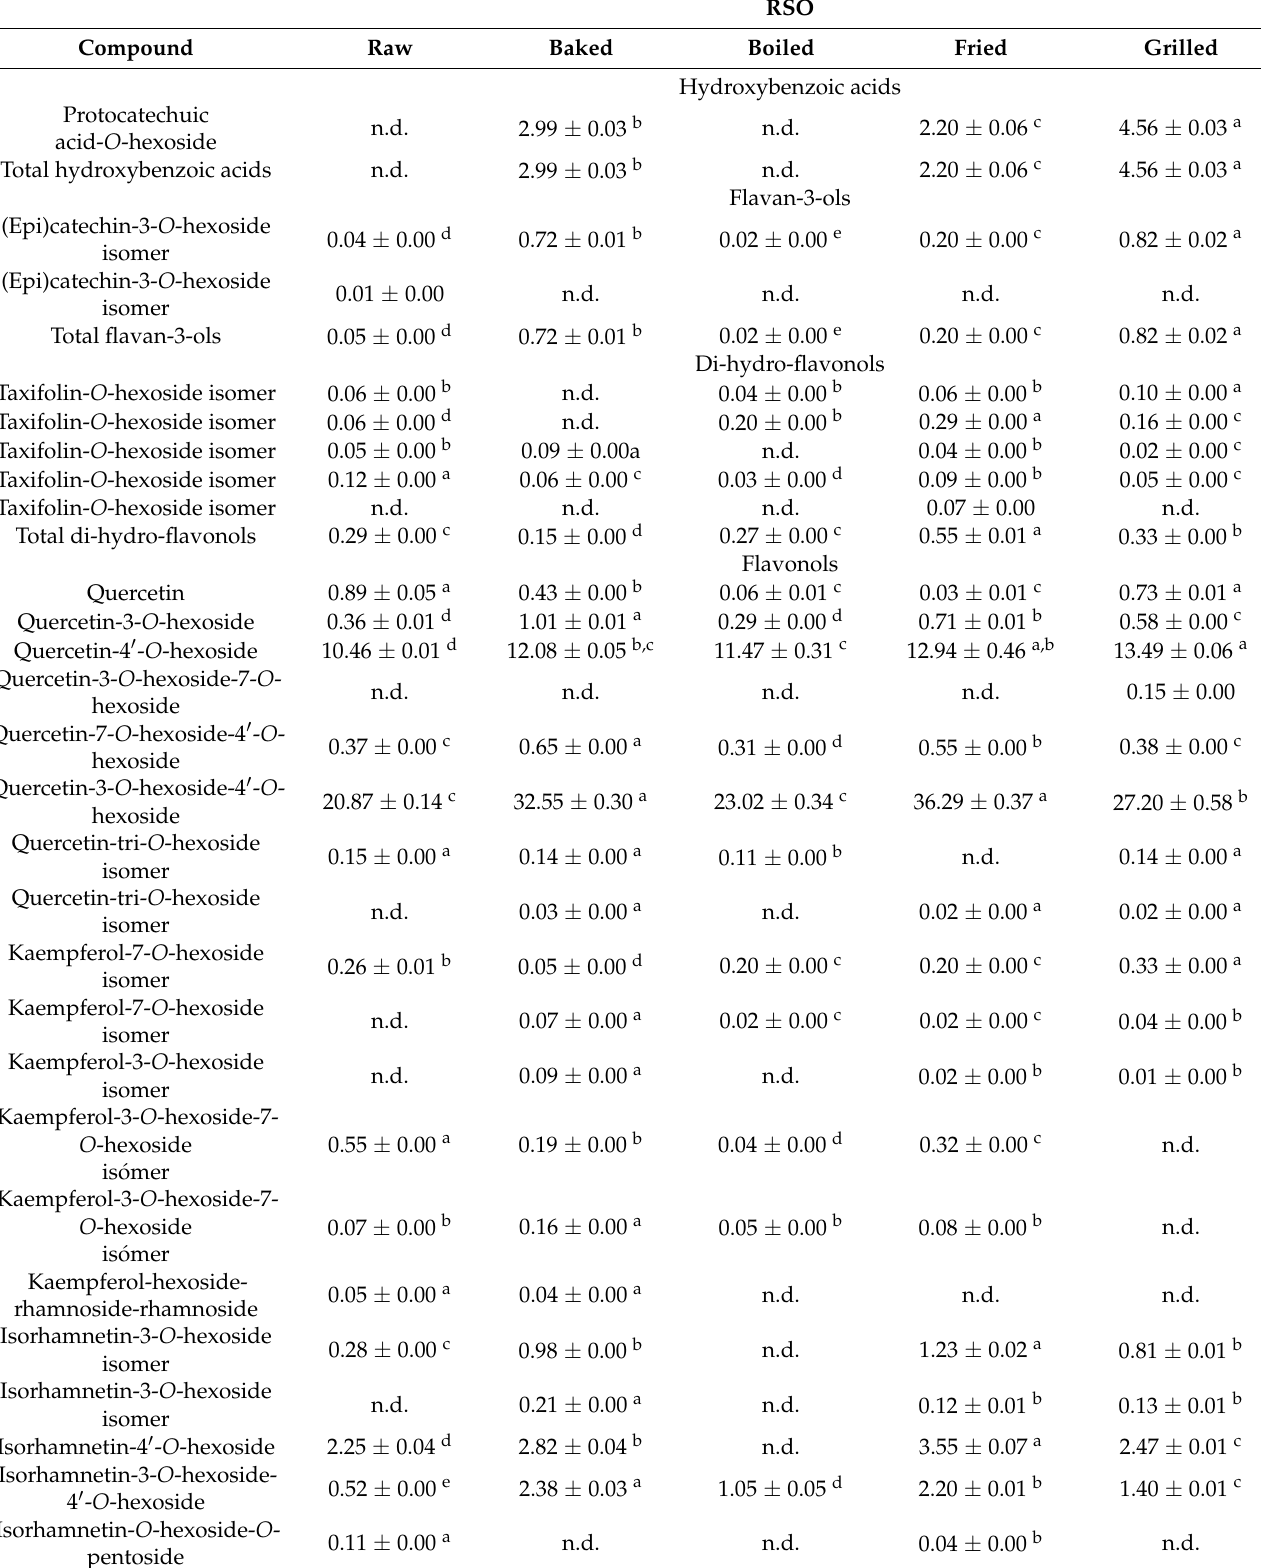
Table 3. Amount of phenolic compounds in raw and cooked red-skinned onion (RSO). Results are expressed in mg of phenolic compound/100 g of raw or cooked